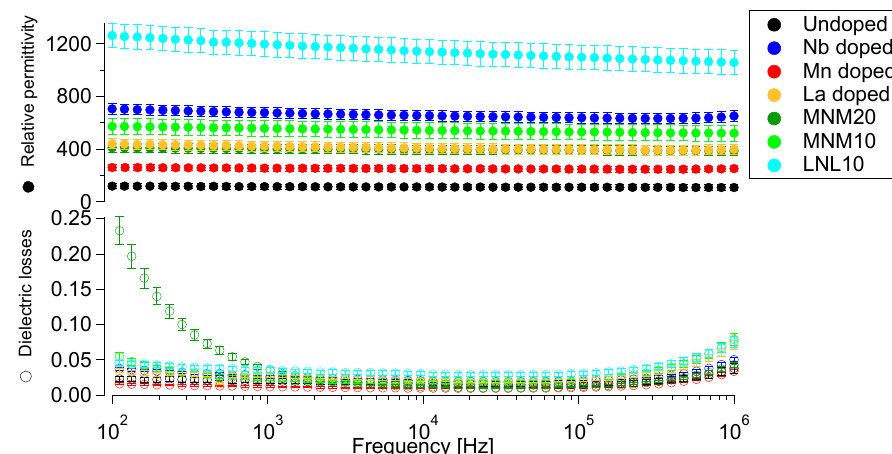
Figure 3. Temperature dependence of the relative permittivity and dielectric losses at 100 kHz of Nb- and La-doped BaTiO 3 films and of an LNL10 multilayer structure.